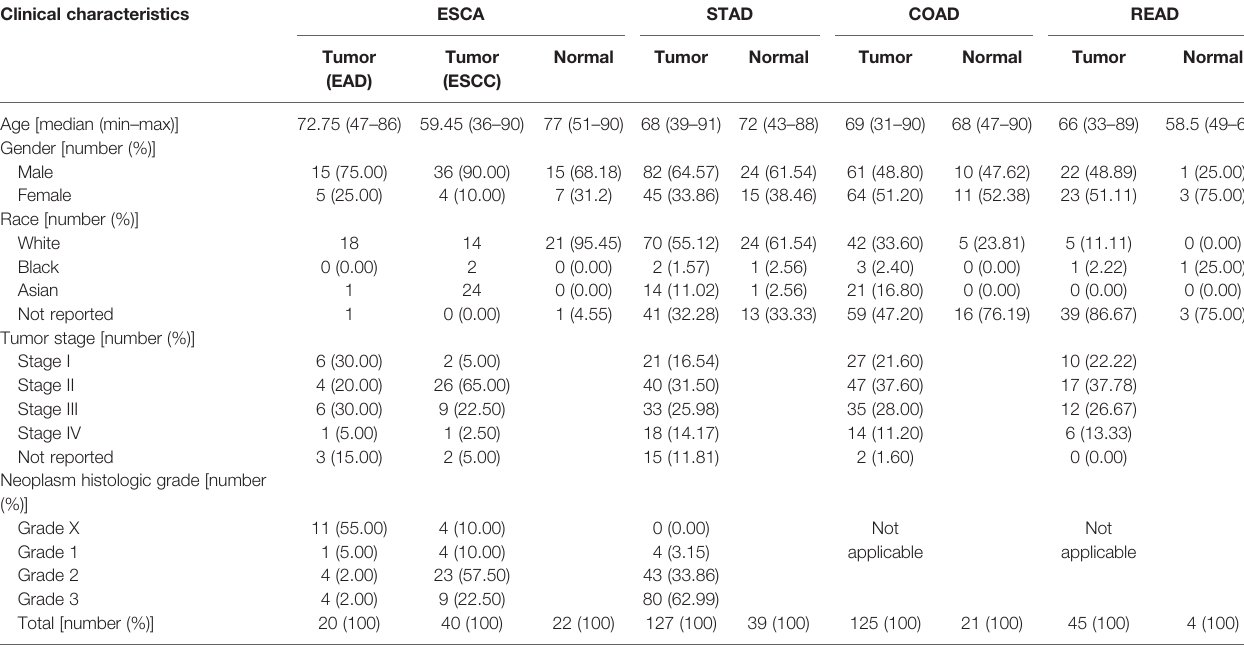
TABLE 1 | Clinical characteristics of the four types of gastrointestinal tumors in thisstudy(derived from The Cancer Microbiome Atlas and The Cancer Genome Atlas databases). Clinical